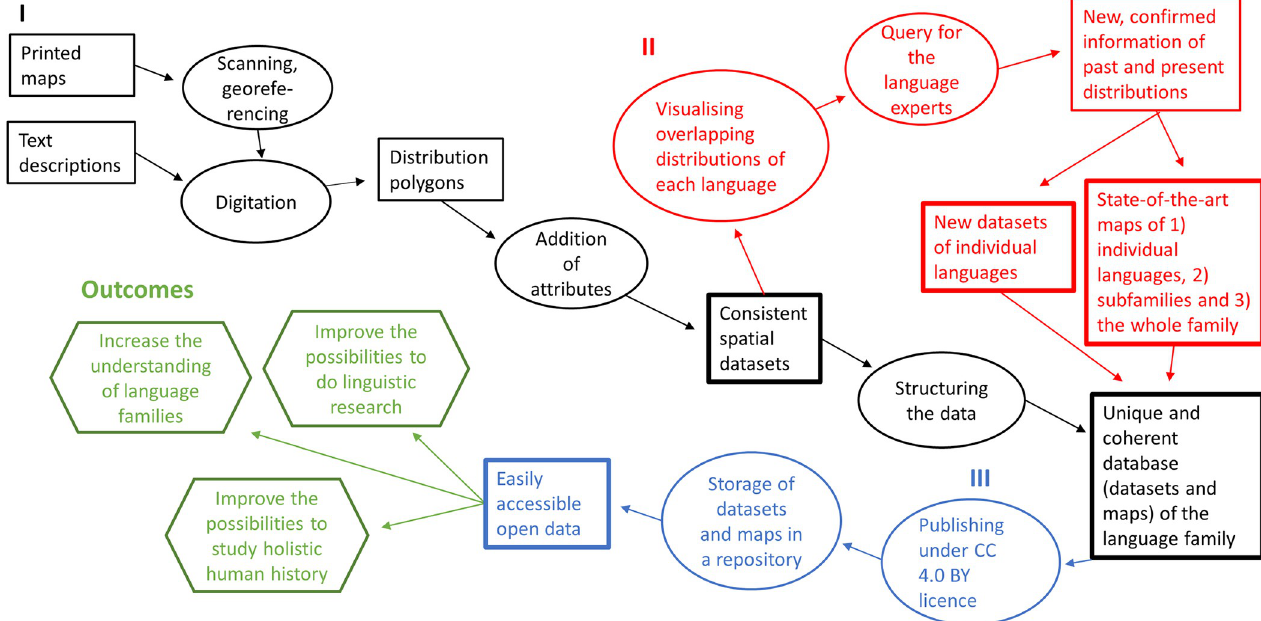
Fig 2. Workflow for best practices in handling of language family data includes three separate phases: I processing and harmonization of spatial data collection: A path from analog and digital source data to a consistent geospatial database, II visualization combined with queries from experts in the case of lesser-studied languages, and creation of improved new maps based on updated information, III data sharing. The outcomes of the best practices increase research opportunities and general understanding of language distributions. Original data and output are shown as rectangles, processing as ovals and overall benefits as hexagons. Details of the workflow are described in Section